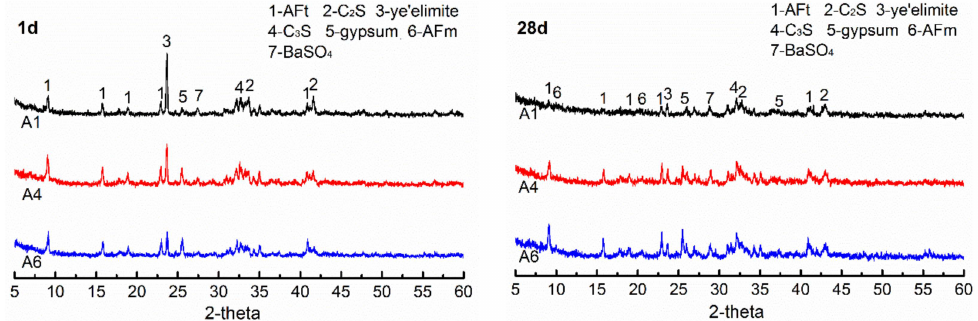
Figure 7. XRD patterns of AMCSA hydration for 1 d and 28 d.